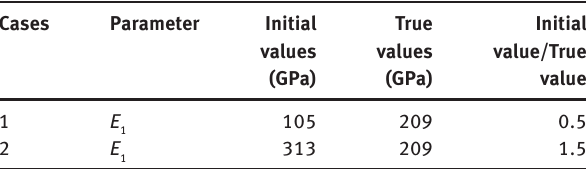
Table 2: Initial values of material parameter in a square FGM plane structure.